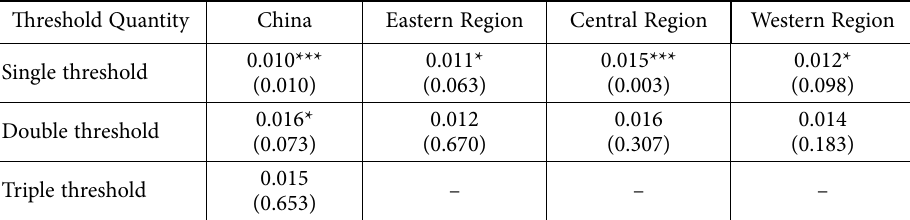
Table 4. Results of the threshold effect test (source: The data in the table are calculated by the software of STATA) Threshold Quantity